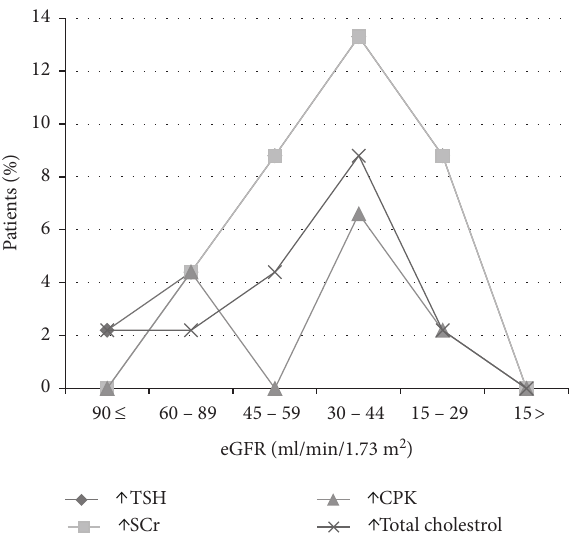
Figure 2: Distribution of patients with primary hypothyroidism, elevated serum CPK, serum creatinine, and total cholesterol in different stages of decreased eGFR. The first top line shows elevated serum TSH greater than or equal to 10mIU/ml (solid quadrangle), second line is indicative of elevated serum creatinine greater than or equal to 1.1–1.3mg/dl (solid square) that forms overlapped line with elevated serum TSH, third line is indicative of elevated total cholesterol (cross mark), and the fourth bottom line is indicative of raised creatine phosphokinase (solid triangle). CPK, creatine phosphokinase; eGFR, estimated glomerular filtration rate; SCr, serum creatinine; TSH, thyroid-stimulating hormone.